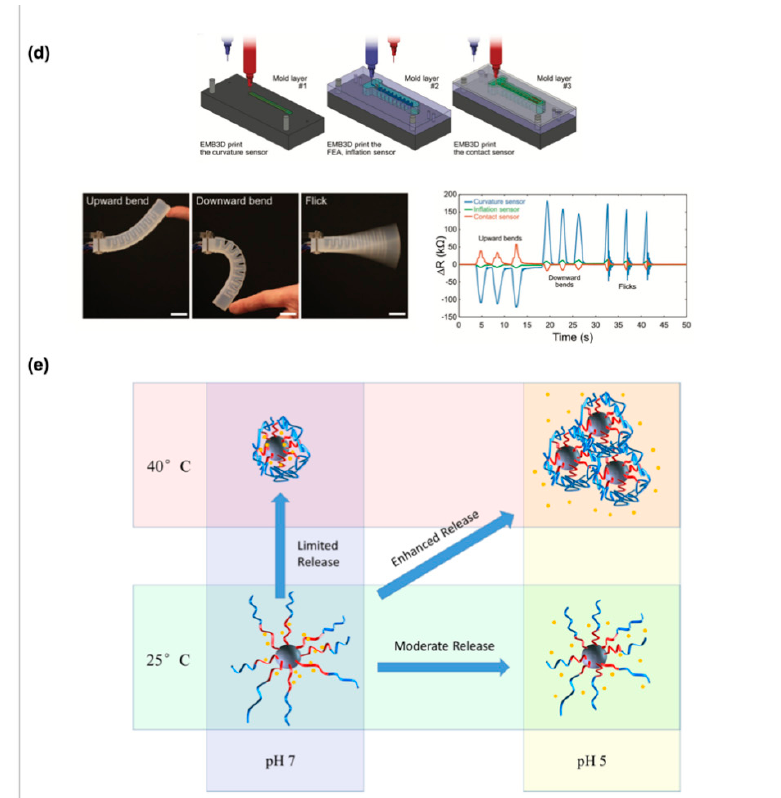
Figure 1. ( a ) Fabrication process of a curved microneedle by using an acupuncture needle as a mater structure to make a negative polydimethylsiloxane (PDMS) model. Then, filling melt poly(lactic acid( (PLA) into the negative PDMS model, a curved PLA microneedle can be obtained through the casting process. (Reprinted with permission from [30] Copyright (2015) MDPI publishing.); ( b ) The light-emitting diode (LED) light connected with a carbon nanotube (CNT) ink-printed circuit on a paper before and after folding. Moreover, the CNT ink-printed fibers could be encapsulated in a hydrogel and used as a 3D biosensor for the detection of cardiac electroactivity. (Reprinted with permission from [31] Copyright (2016) John Wiley & Sons publishing.); ( c ) The morphology and dimensions of a 3D printed ring shape graphene-based biosensor. (Reprinted with permission from [32] Copyright (2018) ACS publications.); ( d ) A 3D printed technique is used to fabricate a somatosensitive biosensor containing a dorsal sensor (layer 1), an actuator features and an inflation sensor (layer 2), and a contact sensor (layer 3). The resistance change could be recorded and be significant distinguished three type of resistance changed behaviors during the upward, downward, flicked movements of somatosensitive biosensor. (Reprinted with permission from [33] Copyright (2018) ACS publications.); ( e ) The sensing mechanism of silica / poly(methacrylic acid) (PMAA)- poly(N-isopropylacrylamide) (PNIPPAM) core-shell nanoparticles indicate that temperature and pH e ff ects contribute to the nanoparticles with the enhanced release and moderate release behaviors, respectively. (Reprinted with permission from [34] Copyright (2017) ACS